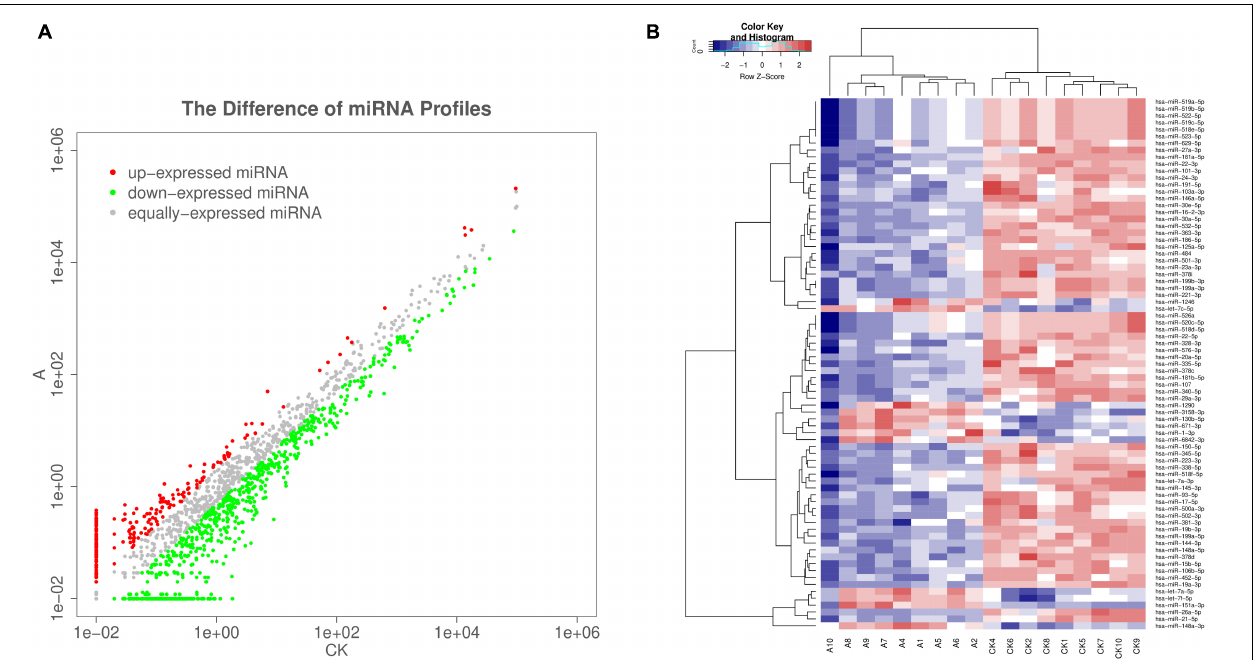
FIGURE 2 | Sequencing-generated exosomal miRNA expression profiles for the serum of women carrying fetuses with VSD ( n = 9) or normal fetuses (control, n = 9). (A) Scatter plots are used to illustrate the differential exosomal miRNA expression profiles between the VSD and control groups. Red, miRNAs with higher expression; green, miRNAs with lower expression; gray, miRNAs with equal expression. (B) Unsupervised hierarchical clustering analysis of miRNAs detected in all 18 samples (A, VSD group; CK, control group). Rows, miRNAs; columns, cases. The color legend across the top illustrates relative miRNA expression levels: blue for low expression and red for high expression (change > 2-fold as a cut-off; p < 0.05; expression level >